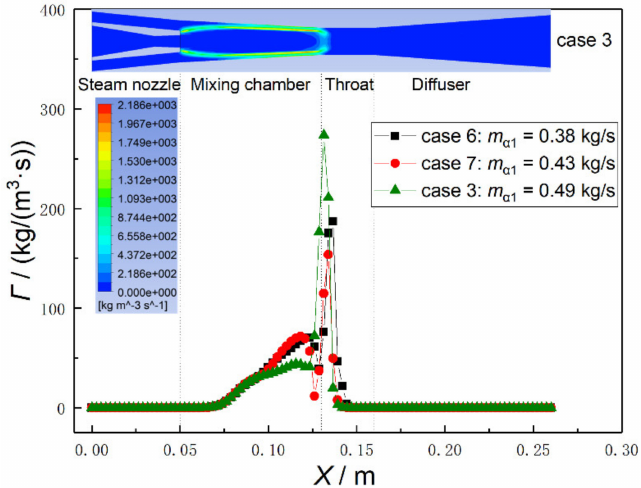
Figure 11. Contours of interphase mass transfer rate for case 3 and axial profiles of interphase mass transfer rates at different water inlet mass flow